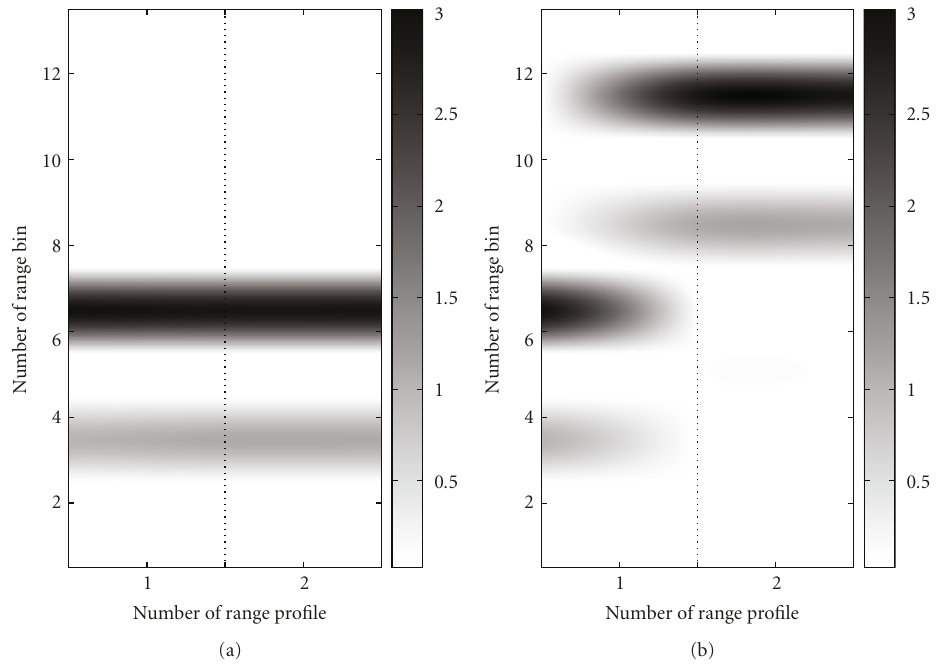
Figure 25: Alignment results for the two simulated range profiles in Figure 24 by applying (a) the proposed technique and (b) the minimum entropy-based